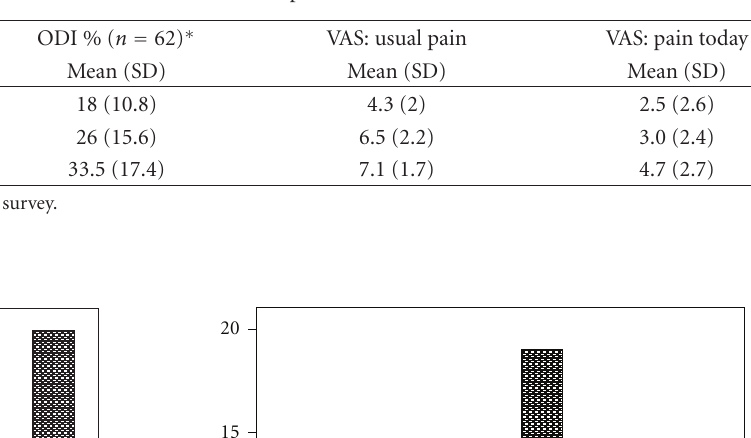
Table 5: The VAS and ODI scores for self report of LPP.